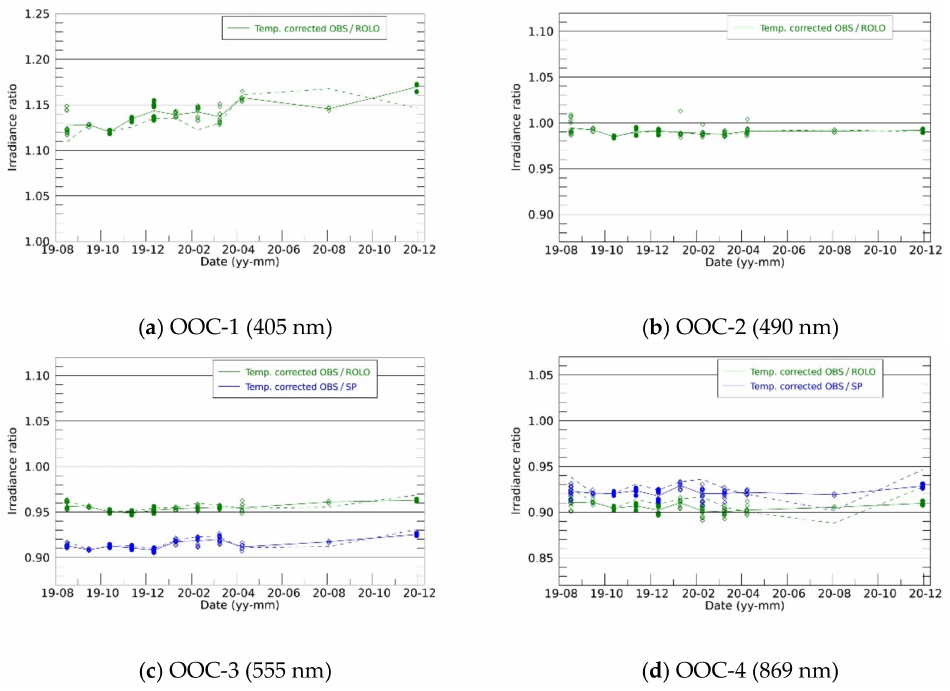
Figure 9. OSR plots from Figure 7, with corrected temperature dependences. Dashed lines indicate the OSRs before the correction.